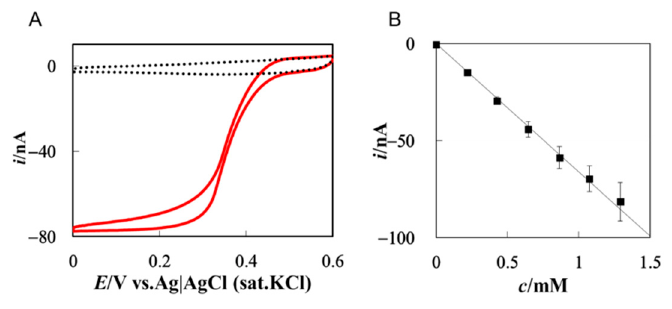
Figure 4. ( A ) Cyclic voltammogram of CueO-modified porous gold microdisk electrode recorded with r = 20 µ m (solid line) with and (dotted line) without oxygen; ( B ) (squares) experimental and (solid line) theoretical calibration curve for the oxygen biosensor. Reprinted from ref. [118], Copyright (2020), with permission from Elsevier.